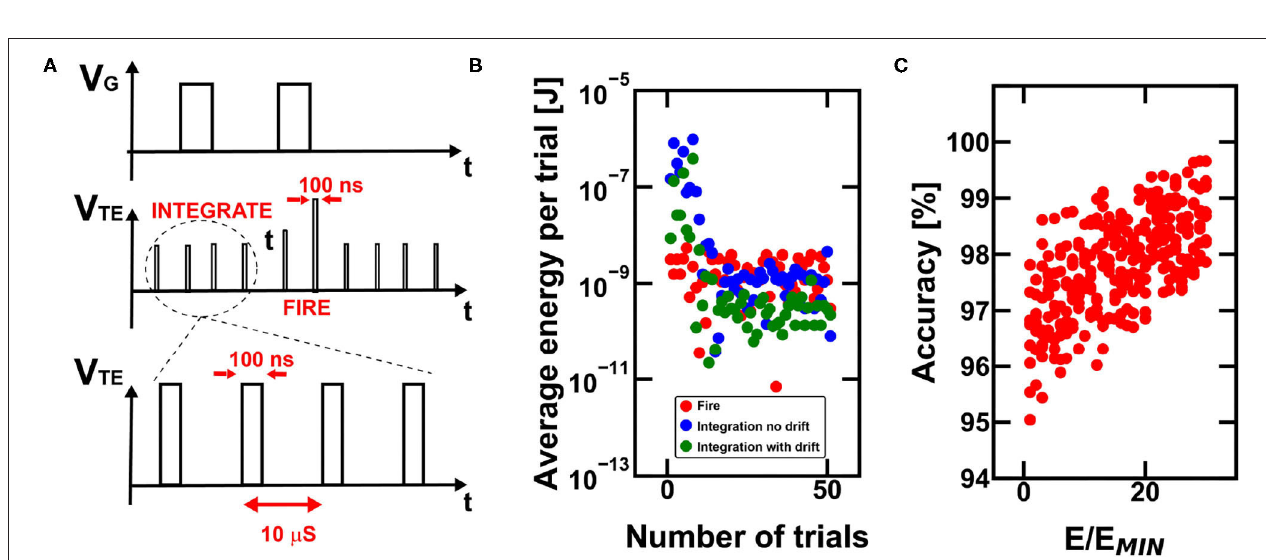
FIGURE 10 | (A) Burst-mode operation for power-saving during PCM-based working procedure of the RNN. (B) Note that the required energy for the operations carried out by the RNN is dependent on the grade of specialization of the network and on the final achievement with respect to the disclosure of the escape path. In fact, once the final reward is found, the network progressively decreases the total need of integration energy. Note that the simulated energy consumption reduction also comes with a decrease in the overall accuracy for finding the escape path when conductance drift is considered. (C) Monte Carlo simulations of the global accuracy for the case study maze considering increasing trial and error procedures for the programming of the internal state and of the inter-neuronal synaptic